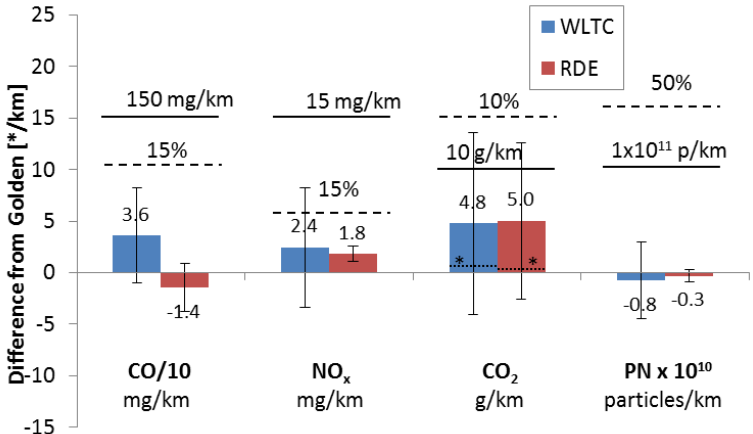
Figure 3. Mean differences of lab PEMS from Golden PEMS for the WLTC (five labs) and RDE cycle (two labs). Although not applicable, dashed lines show relative permissible tolerances and solid lines show absolute permissible tolerances [16,17]. Error bars show one standard deviation. Dotted lines with asterisk (*) show CO 2 differences excluding one laboratory.